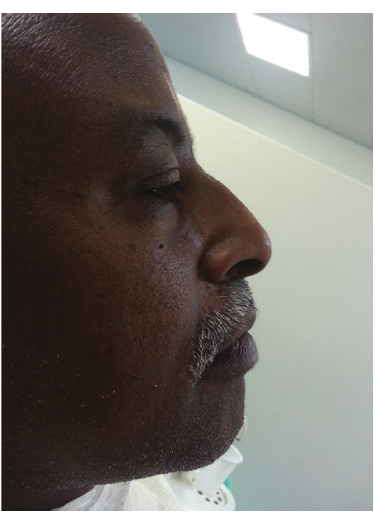
Figure 8: Reestablished lip support and lip